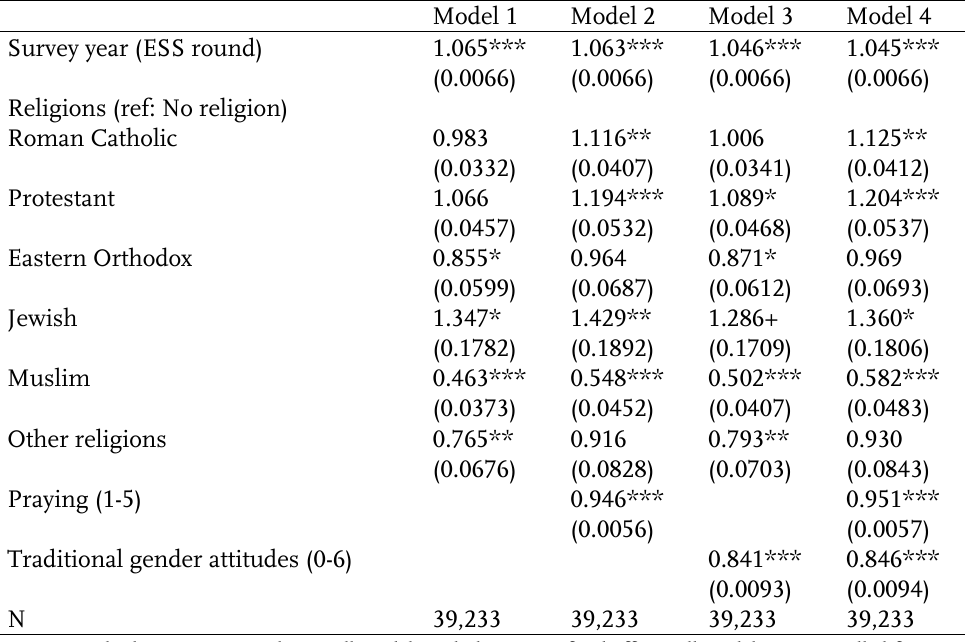
Table 4 : Odds ratios for the effects of religiosity and gender role attitudes on the likelihood of